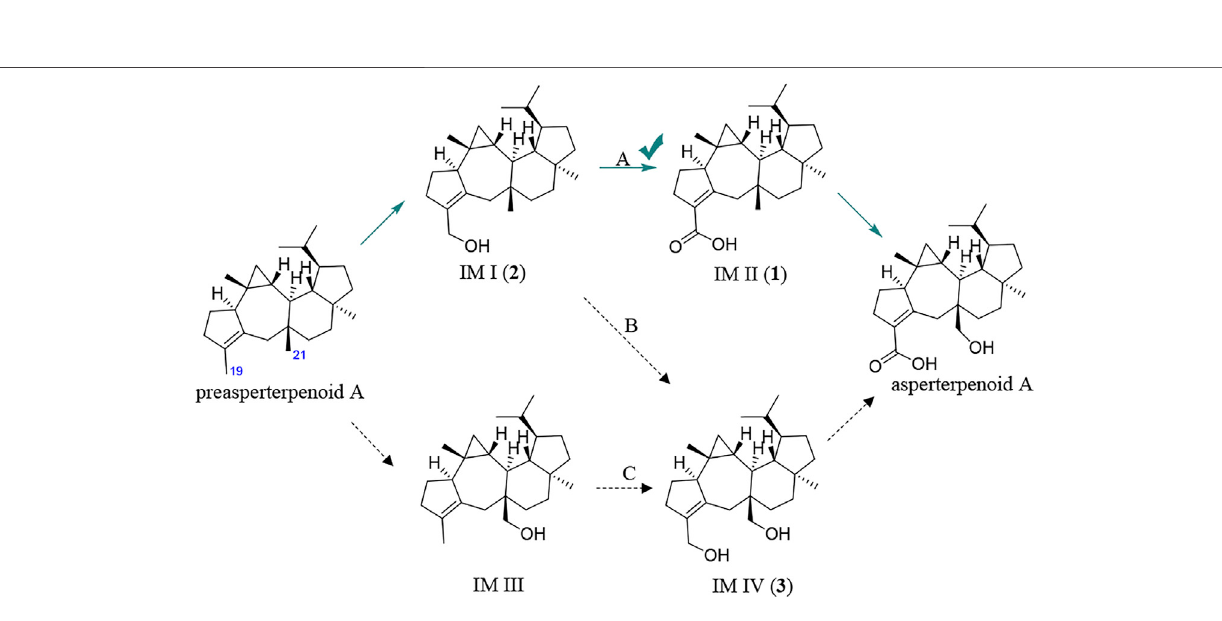
FIGURE 6 | Main pathway for AstB enzyme catalyzing